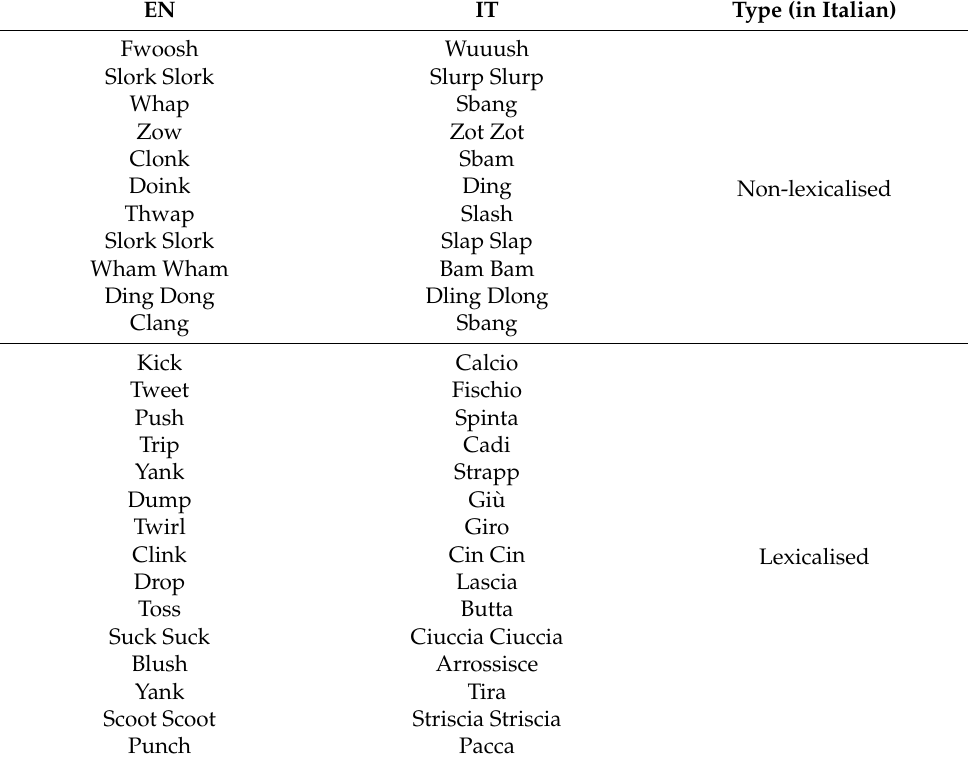
Table 3. List of ‘partial substitution’